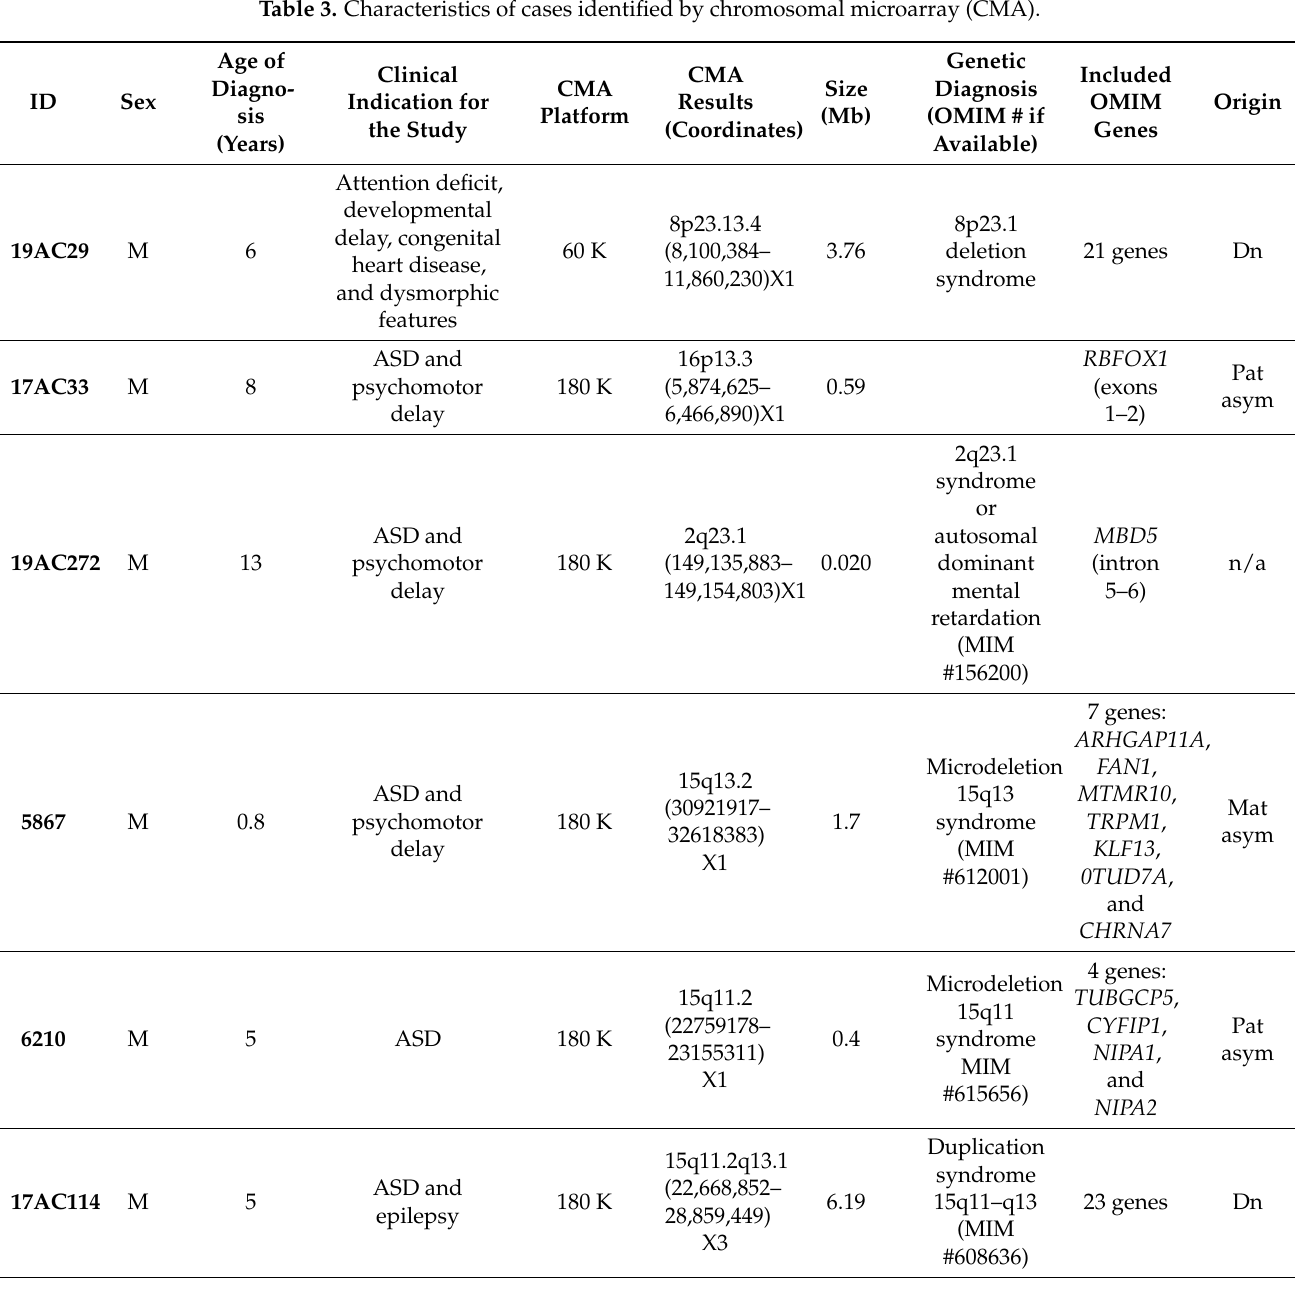
Table 3. Characteristics of cases identified by chromosomal microarray